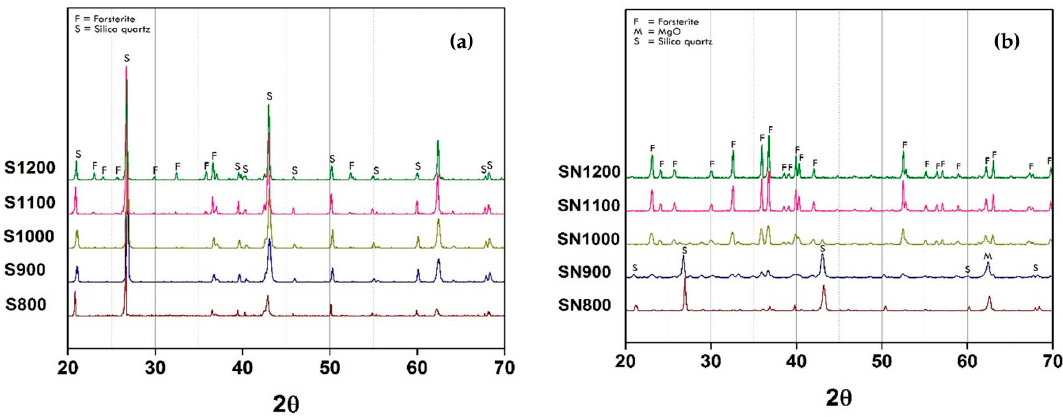
Figure 1. X-ray diffraction (XRD) patterns of as-calcined forsterite powder at various temperatures between 800 and 1200 ° C by mixing reagent-grade SiO 2 : ( a ) Without NaF mineralizer; ( b ) Added 5 wt. % of NaF.